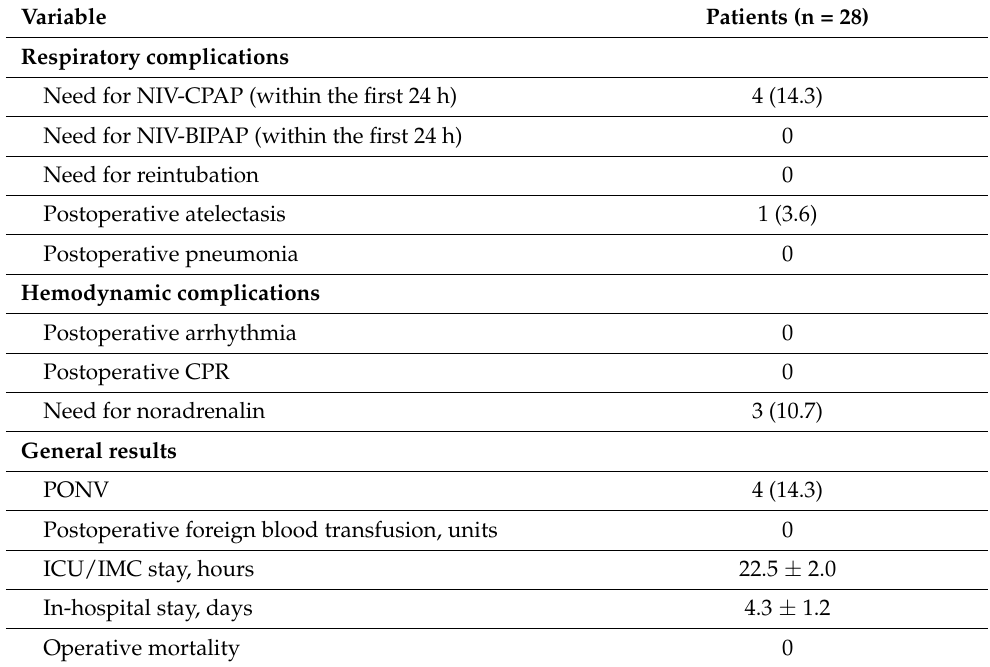
Table 5. Postoperative